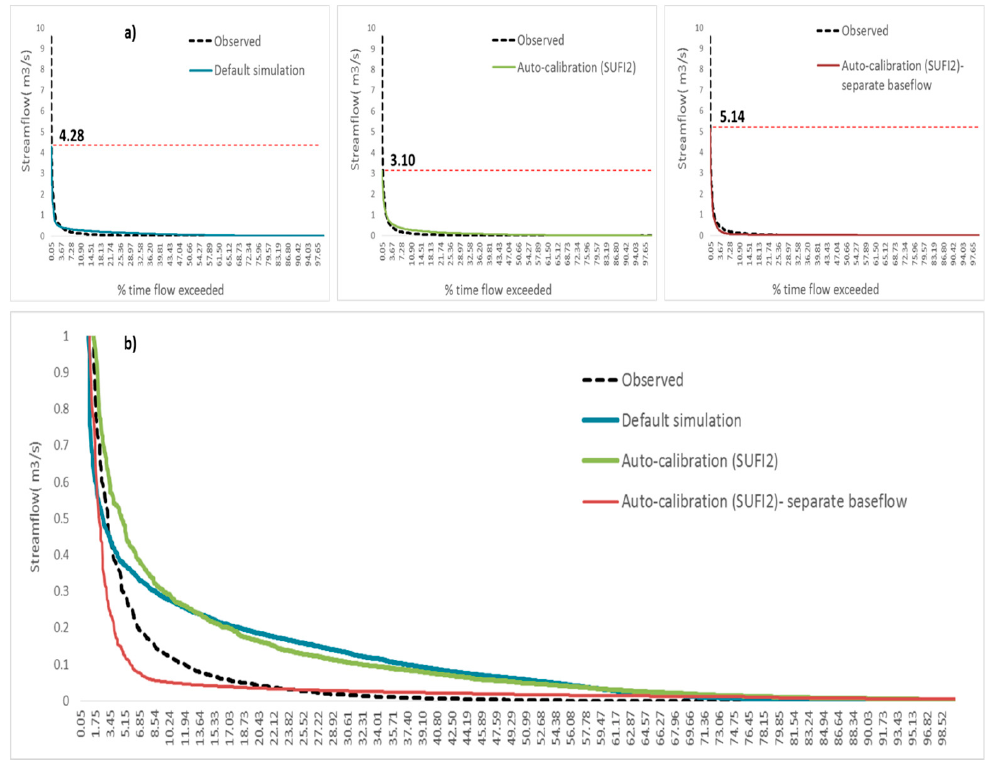
Figure 4. Daily observed and simulated flow duration curves of the Kersbrook catchment. ( a ) Highlight peak flow parts. Bold numbers indicate maximum flows; ( b ) Highlight low flow parts. Table 2. SWAT model performance on a daily time step for the Kersbrook catchment using modified NS objective function (with separate base ‐ flow).